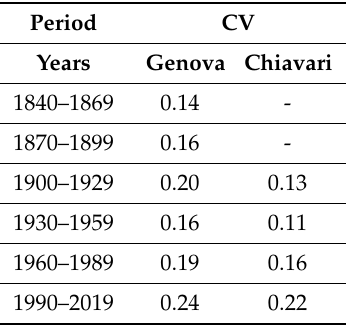
Table 10. The Rainfall Rate Coefficient of Variation (CV) for Genova and Chiavari rain gauges, computed over 30 year periods.